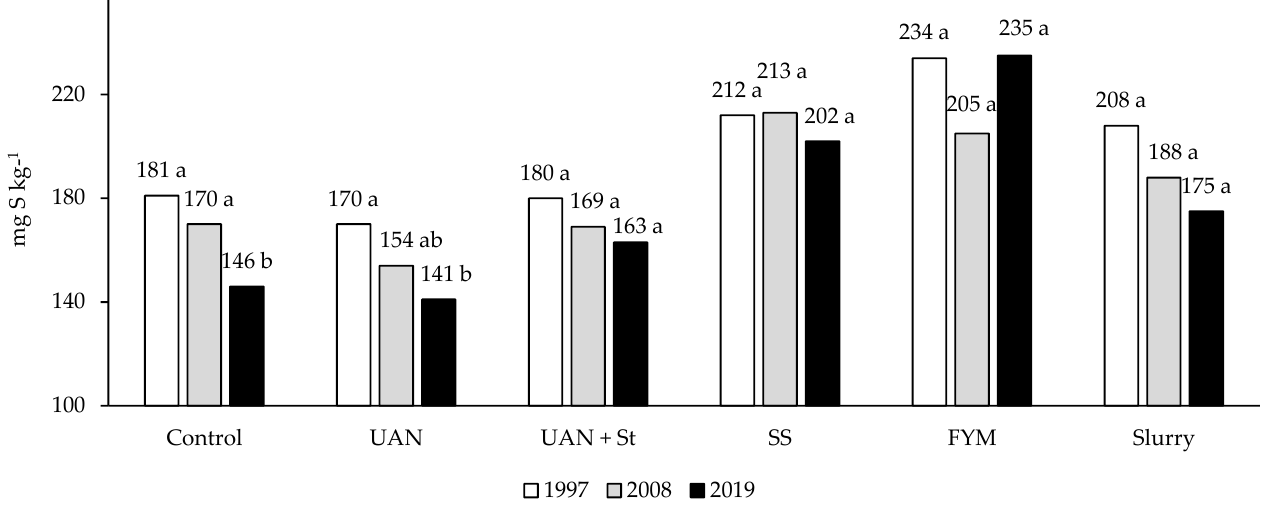
Figure 8. Content of organic sulfur fraction (S org ) in topsoil. Different letters describe statistically significant differences between years within the treatment. Tukey HSD test ( p < 0.05), ( n = 4). Table 9. Relative changes (%) in the content of respective sulfur fractions in topsoil. Values represent relative content in the year 2019 in comparison with the year 1997 (100% = content in 1997). Mean plus standard deviation (SD).